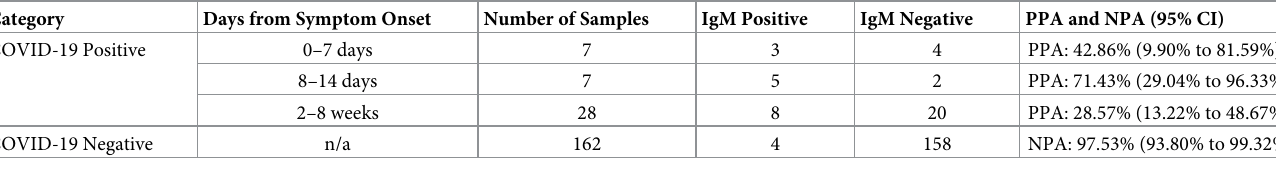
Table 1. Positive Percent Agreement (PPA) and Negative Percent Agreement (NPA).